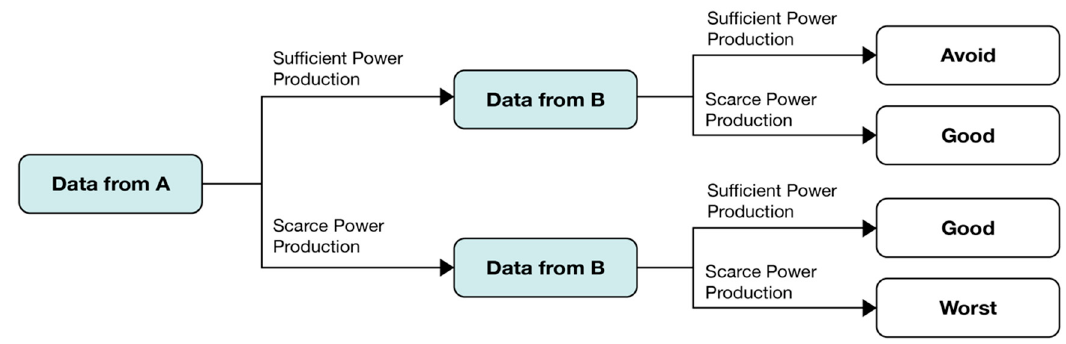
Figure 2. A description of power production situations based on a renewable/non-renewable energy source as an extensive-form game.